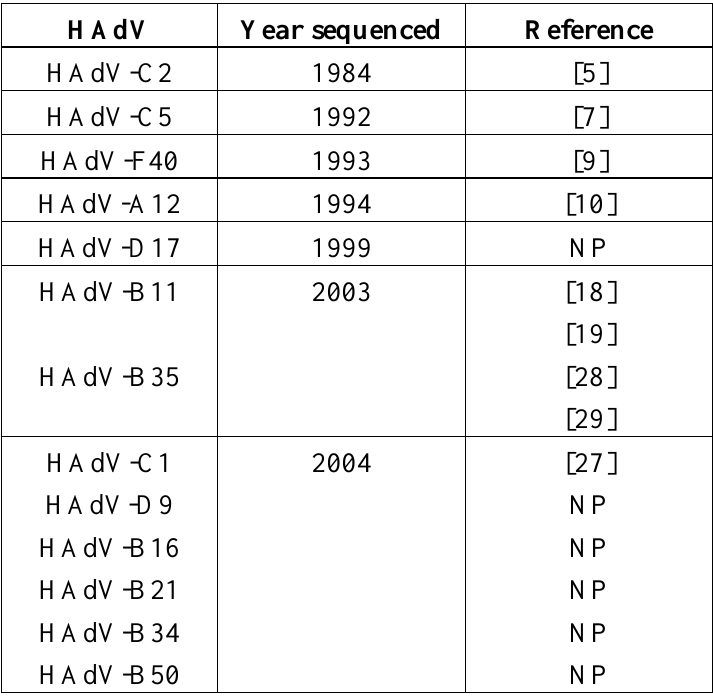
Table 1. Timeline of HAdV